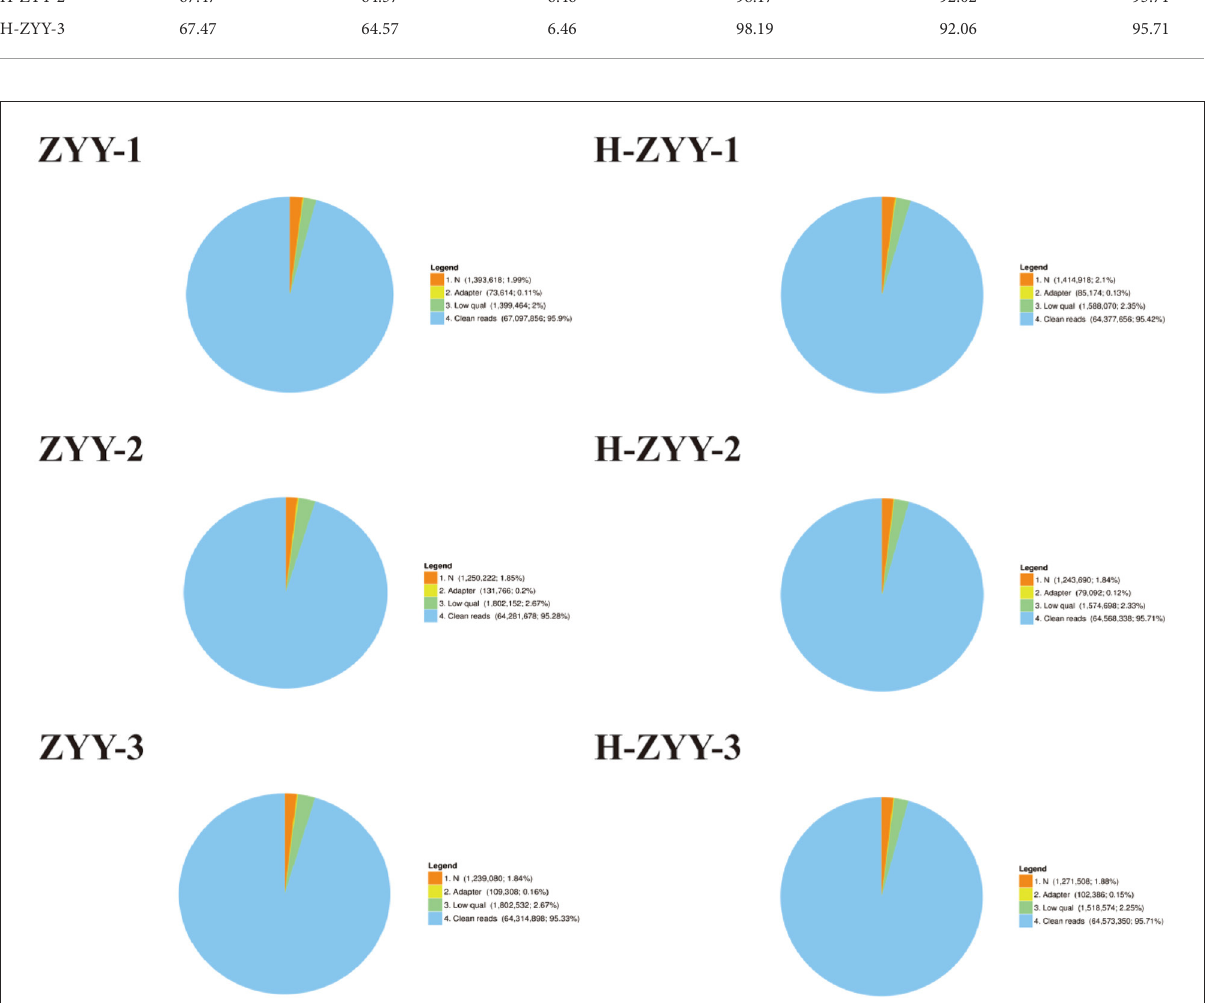
FIGURE3 Comparison of raw reads in six RNA libraries. “Clean reads” represent the elimination of reads containing adaptor; “N” represents reads accounting for over 10%; “low quality” represents remaining reads after the number of bases with quality value (Q) ≤ 5 is over 50% of all reads. Numbers in brackets indicate the percentage of reads of each